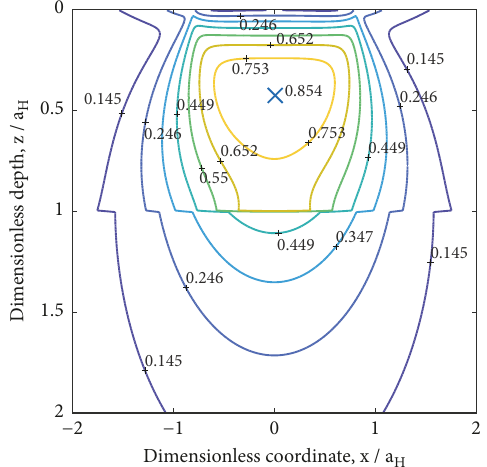
Figure 12: Iso-contours of dimensionless von Mises equivalent stress 𝜎 𝑉𝑀 /𝑝 𝐻 in the plane 𝑦 = 0 , ℎ/𝑎 𝐻 = 1 , and 𝐸 1 /𝐸 2 = 2 .